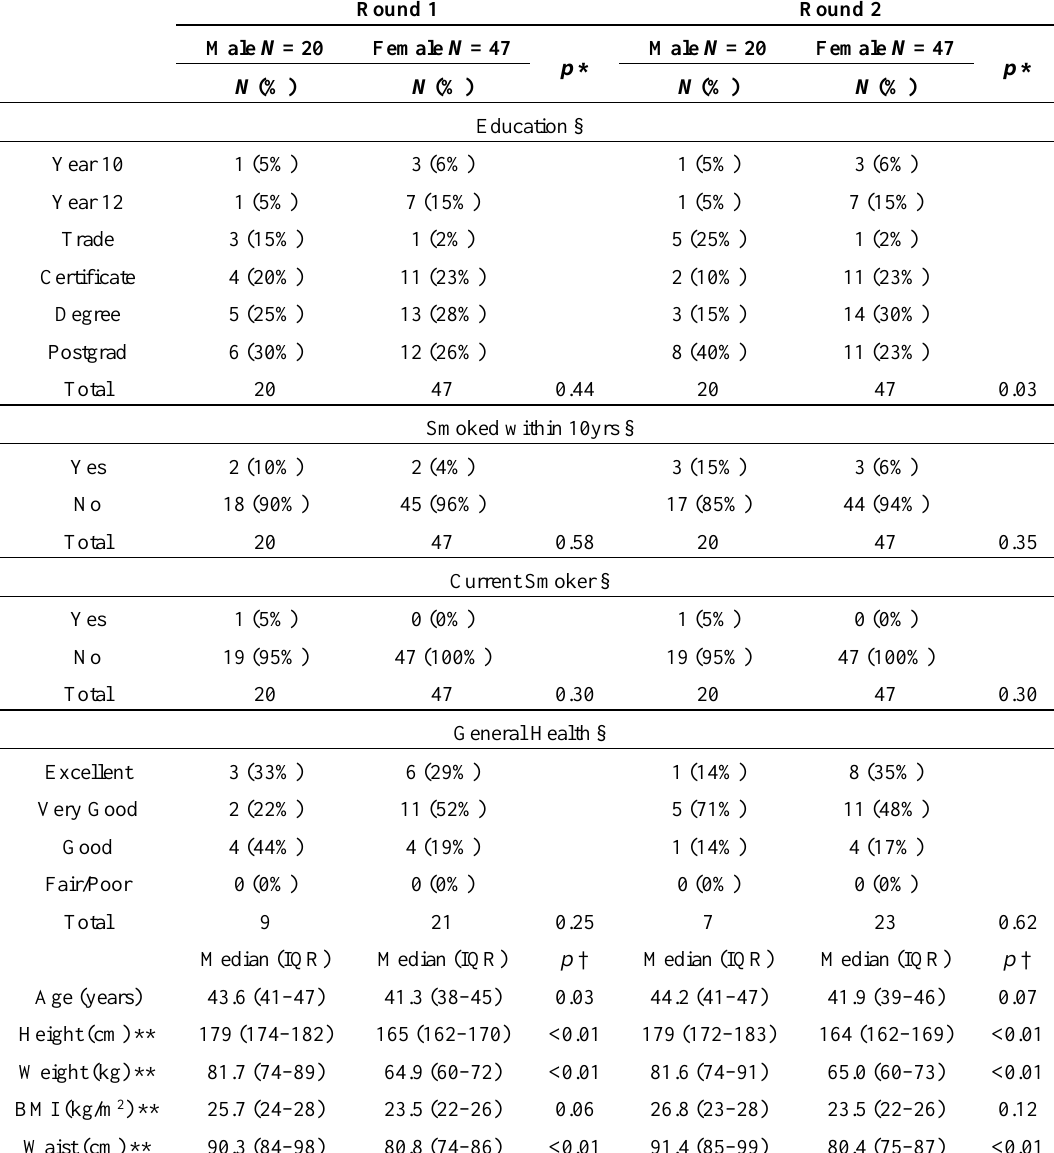
Table 1. Demographic and anthropometric data (151 observations on N = 67 participants (31 male) in 64 families). * Fisher’s exact test of homogeneity; † Wilcoxon rank-sum test for equality of populations; § No significant difference by gender in Round 1, Round 2 or in total according to the exact symmetry test of homogeneity for paired data; ** No significant difference by gender in Round 1, Round 2 or in total according to the Wilcoxon signed-rank test for equality of distributions on paired data.